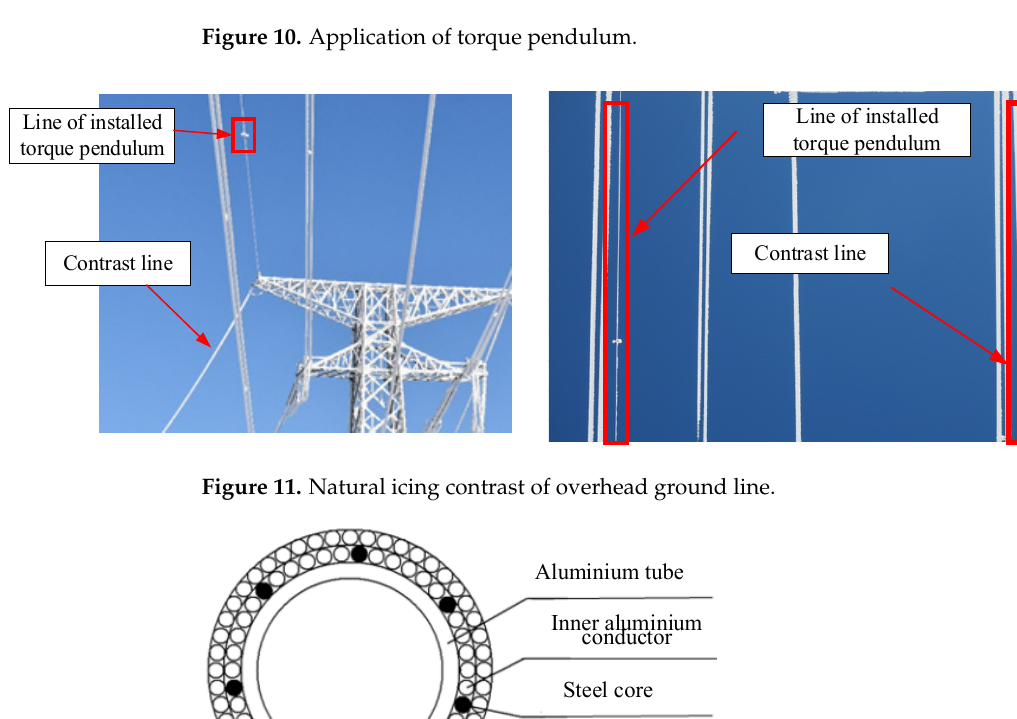
Table 2. Comparison of advantages and disadvantages of different types of DECs.